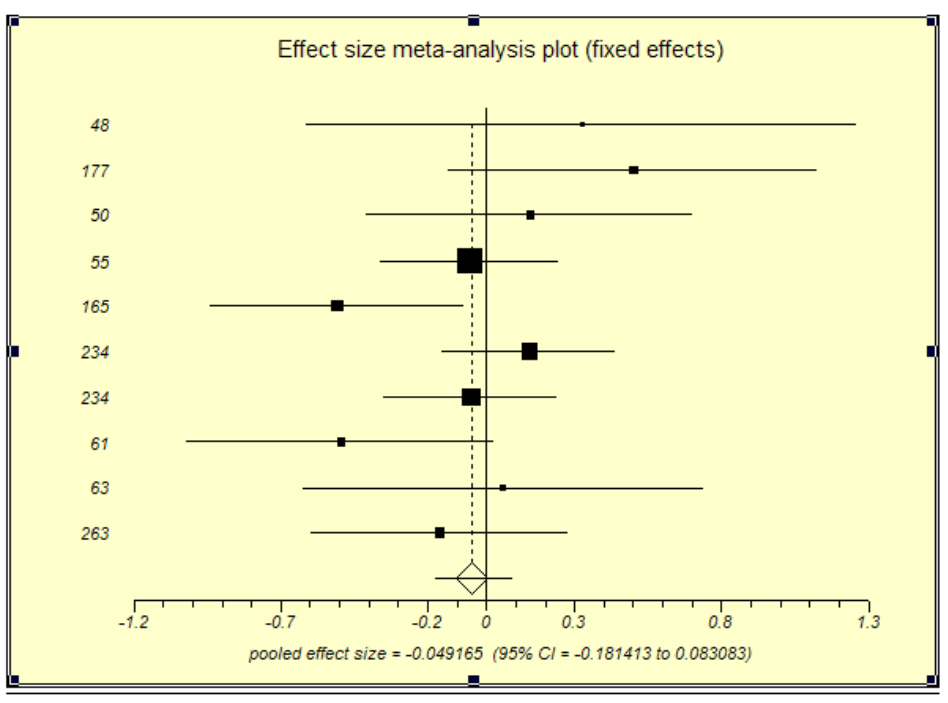
Figure 2. Effect Size Meta-Analysis – Forest Plot